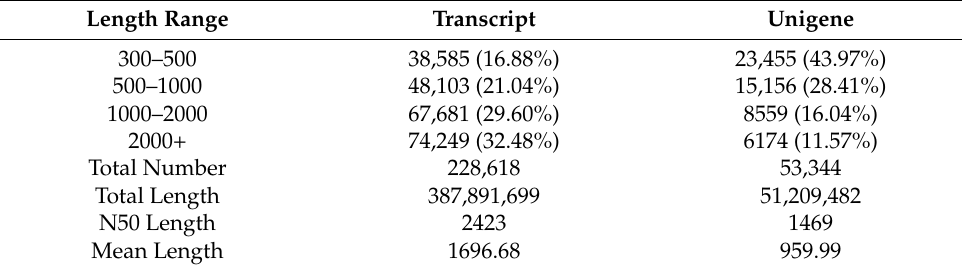
Table 1. Length distribution of unigenes and transcripts.